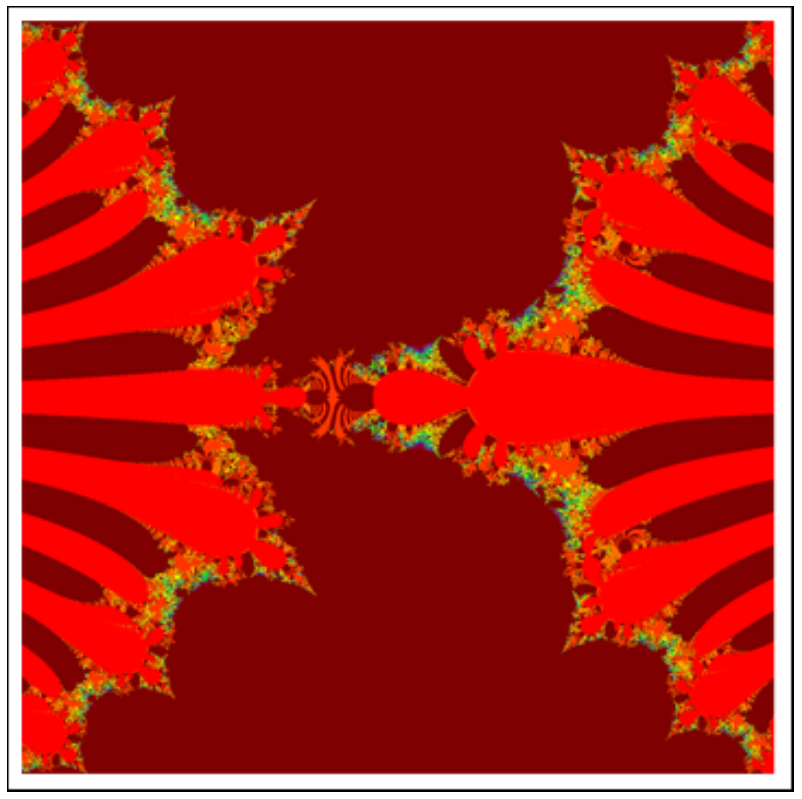
Figure 28. M-set for τ ( z ) = e z 2 + c via DKIS. The image execution time is 829.781 s.